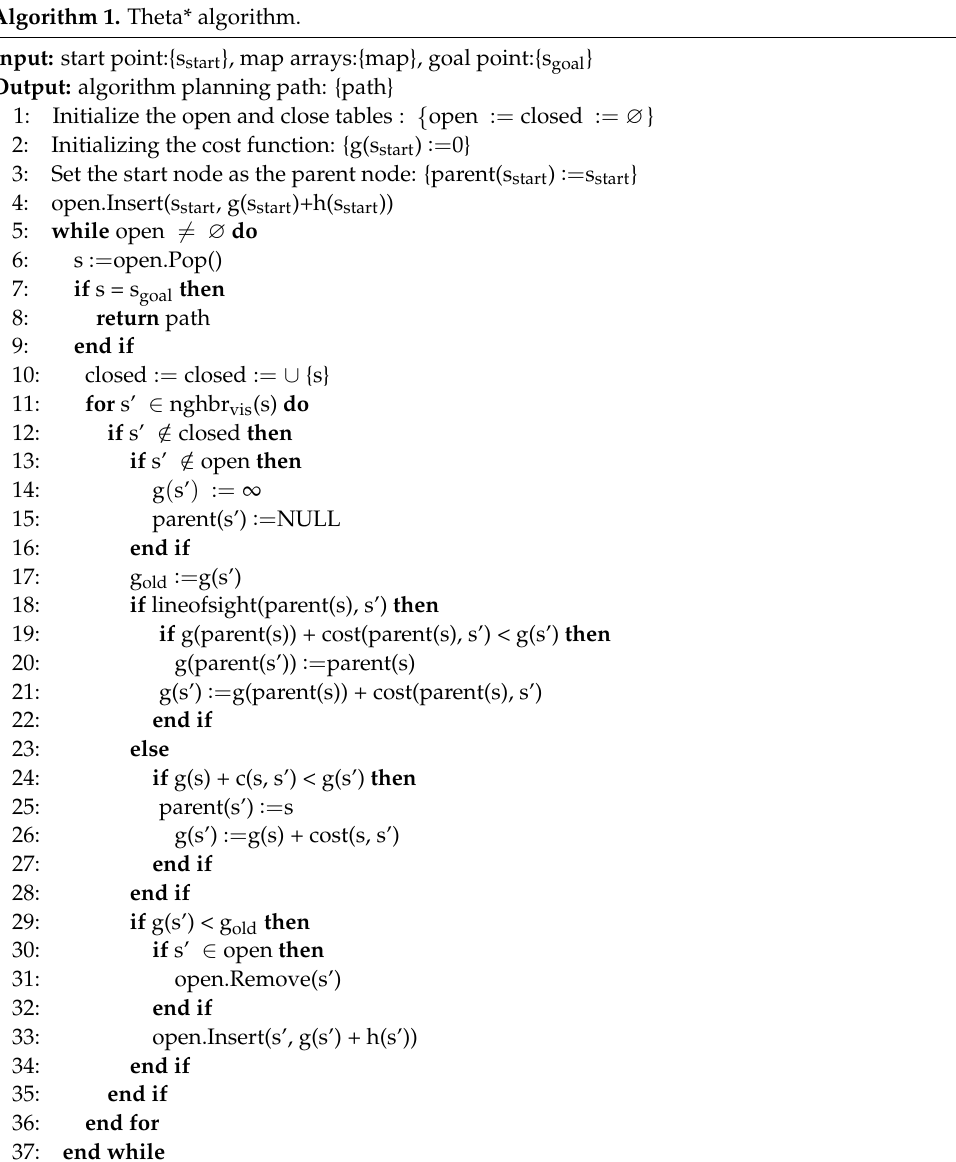
Algorithm 1. Theta*